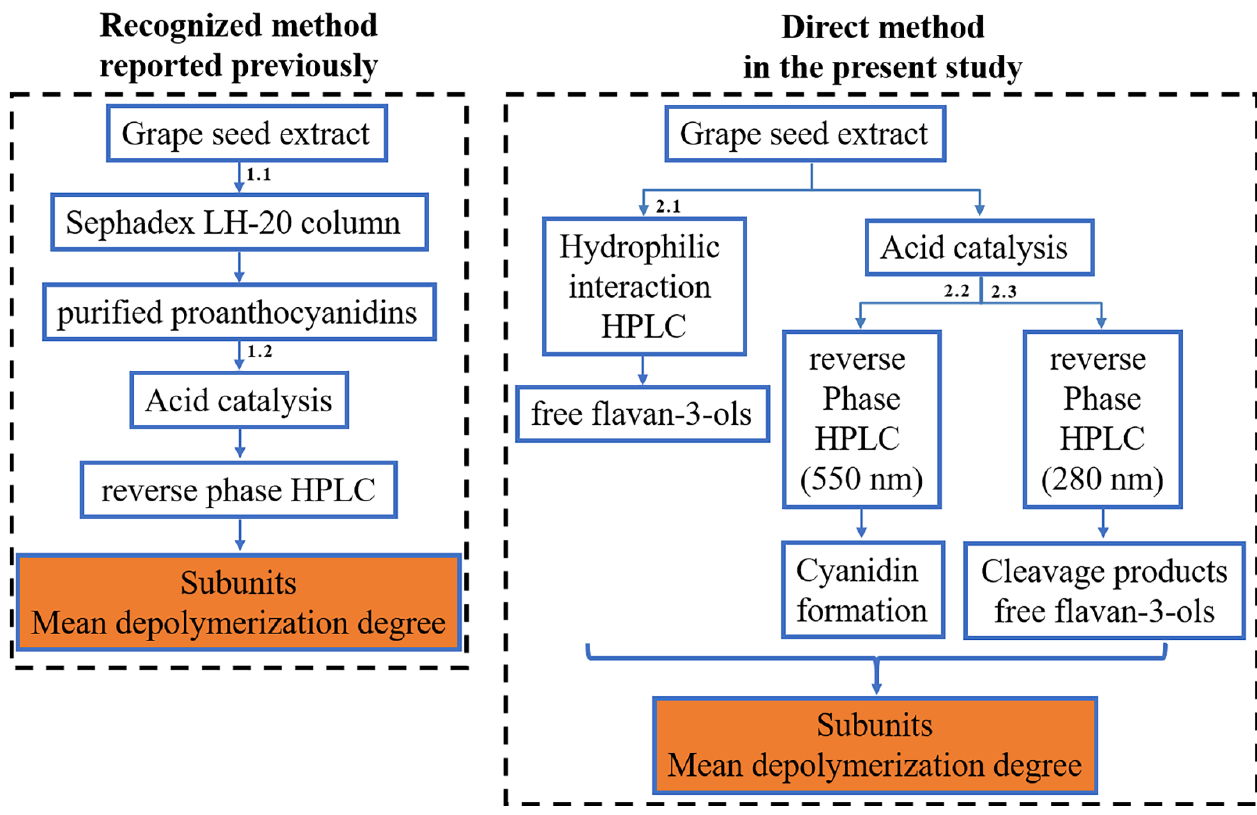
Figure 1. Scheme of the recognized method reported previously and the direct method established in the present study for analyzing the structure of proanthocyanidins in grape seed extract.